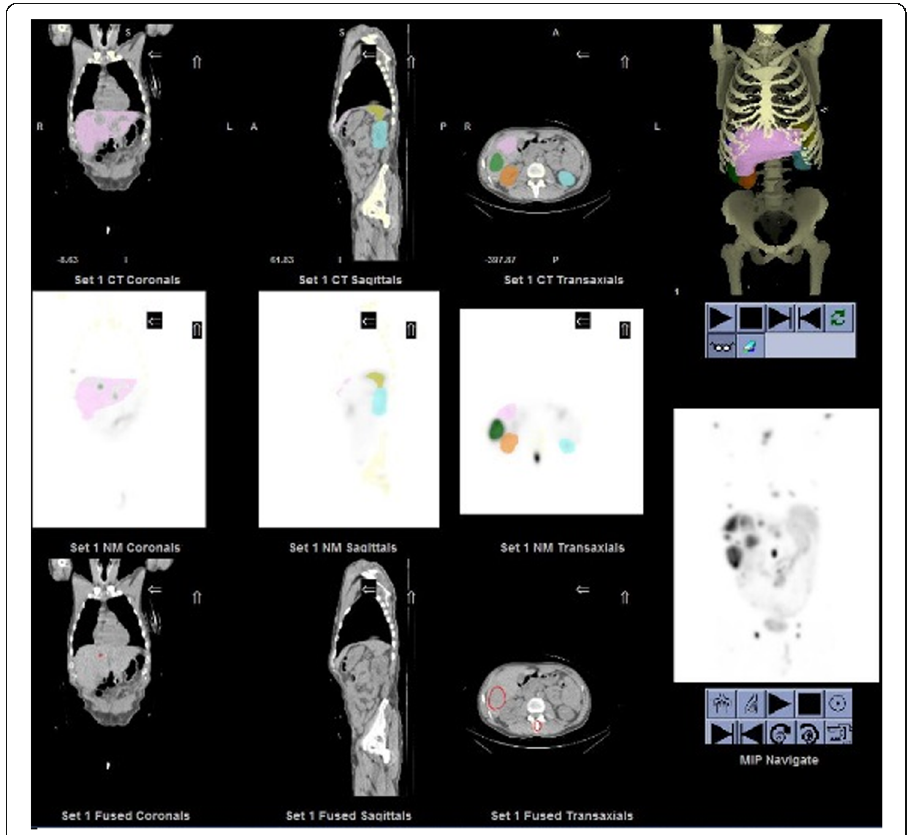
Fig. 2 Volume of interest (VOIs) of the kidneys, liver, spleen, and tumors drawn using the General Electric Dosimetry toolkit